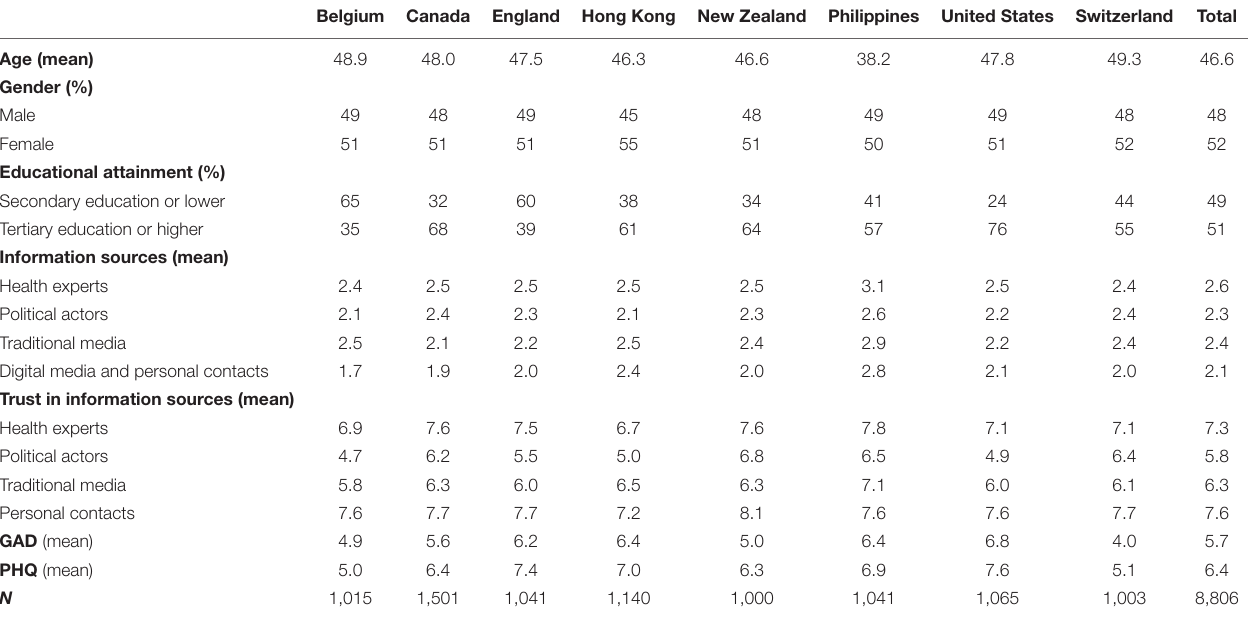
TABLE 1 | Descriptive results of individual-level variables (in% or mean